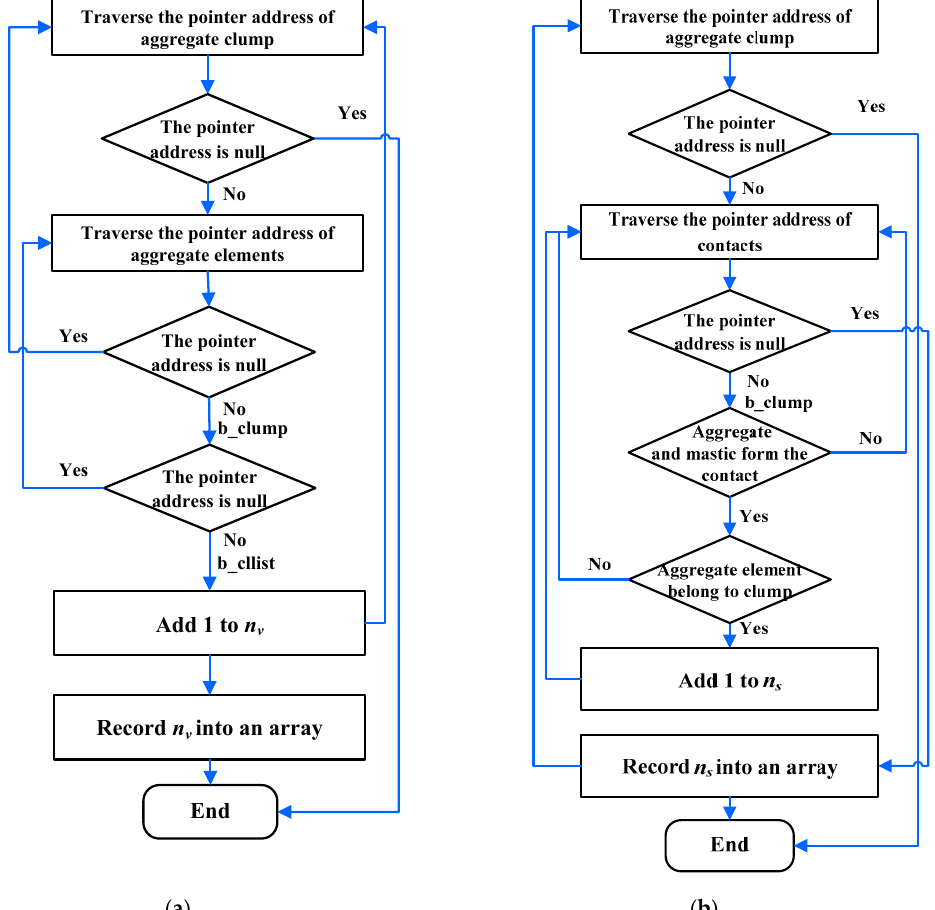
Figure 11. Procedure for quantifying the discrete element number of aggregates: ( a ) quantifying the number of aggregate surfaces; ( b ) quantifying the number that makes up aggregates.